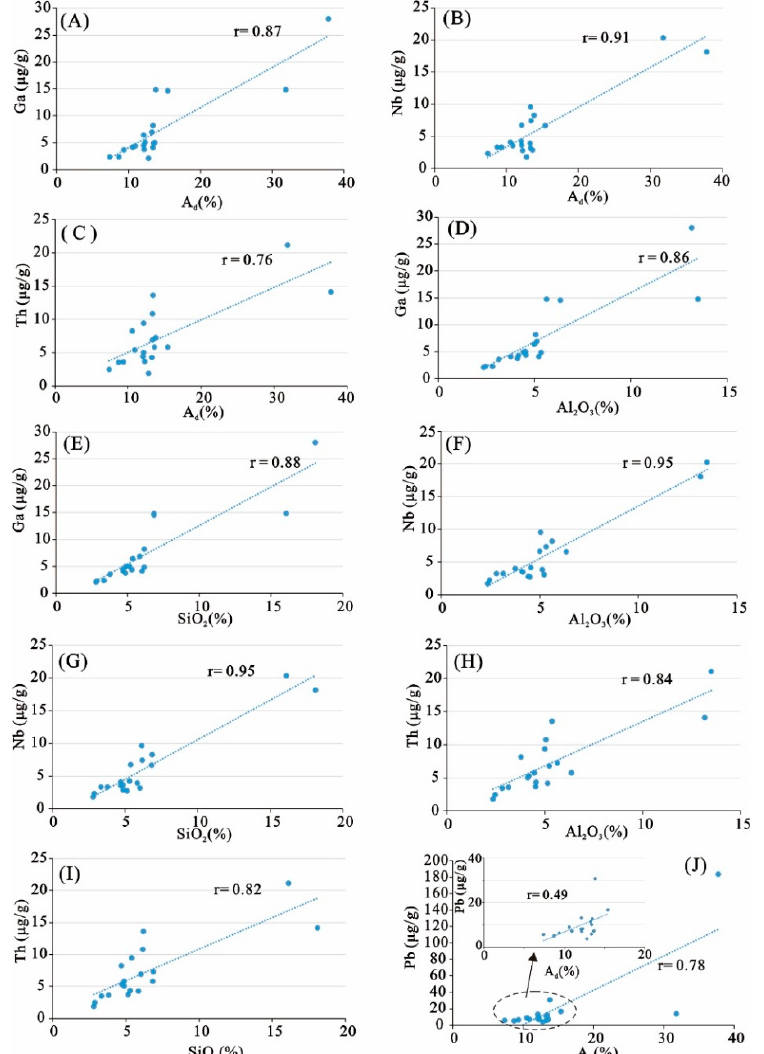
Figure 13. Plots of the concentration of elevated elements and ash yield, Al 2 O 3 , and SiO 2 in coal samples. ( A ) Plot of Ga and ash yield. ( B ) Plot of Nb and ash yield. ( C ) Plot of Th and ash yield. ( D ) Plot of Ga and Al 2 O 3 . ( E ) Plot of Ga and SiO 2 . ( F ) Plot of Nb and Al 2 O 3 . ( G ) Plot of Nb and SiO 2 . ( H ) Plot of Th and Al 2 O 3 . ( I ) Plot of Th and SiO 2 . ( J ) Plot of Pb and ash yield. Table 7. Element affinities between the concentrations of elevated elements and the ash yield or selected elements in coal samples.